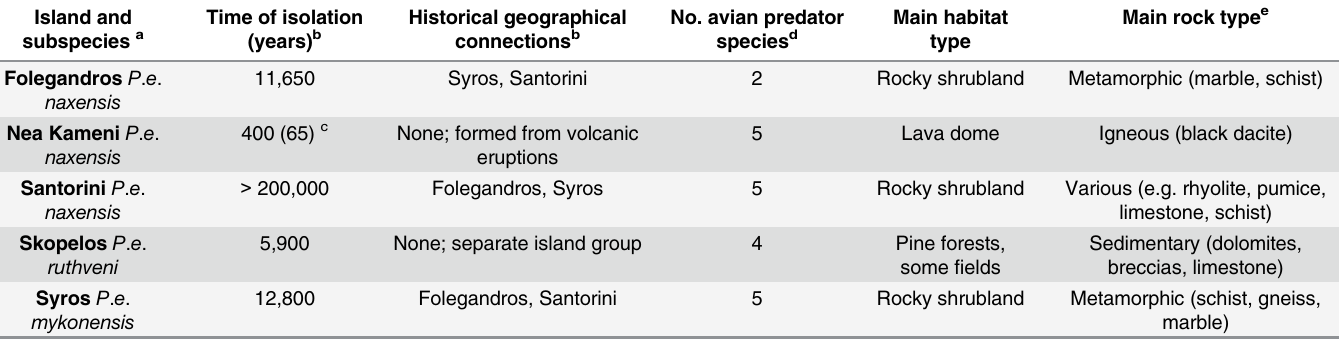
Table 1. Differences in the environments and evolutionary histories of the five focal islands inhabited by populations of Aegean wall lizards ( Podarcis erhardii